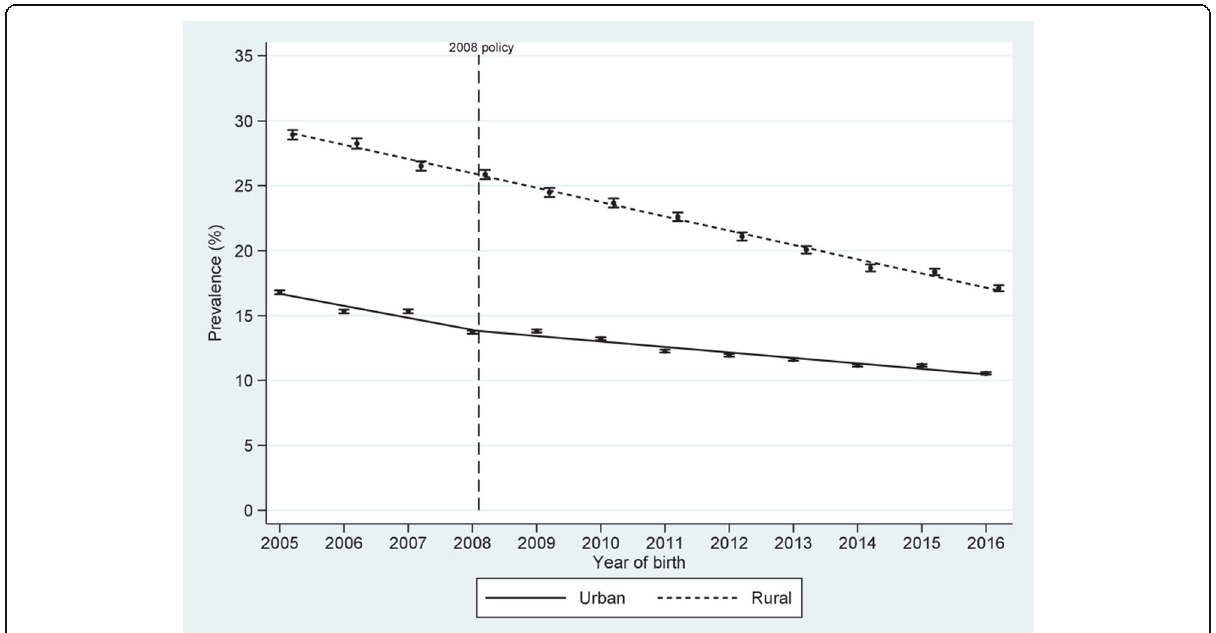
Fig. 3 Trends in small for gestational age prevalence by year and area of residence. Peru, 2005 – 2016. Dots represent proportion with low birthweight (g) and vertical lines represent 95% confidence intervals for the